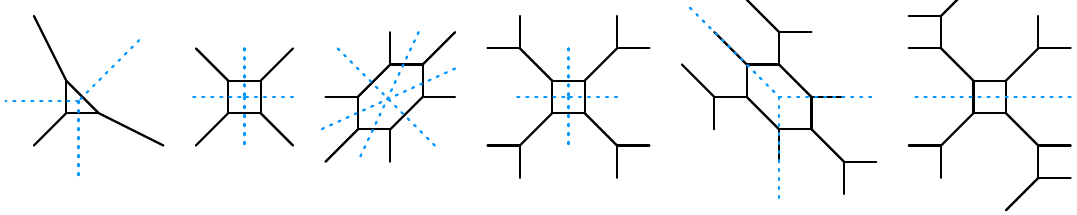
Figure 5 . 5-brane webs for 5d rank-1 theories showing Z N discrete symmetries, where the blue dotted lines denote the action of discrete symmetries. From the left, local P 2 , SU(2) SU(2) + 4 F , SU(2) + 5 F , and SU(2) + 6 F